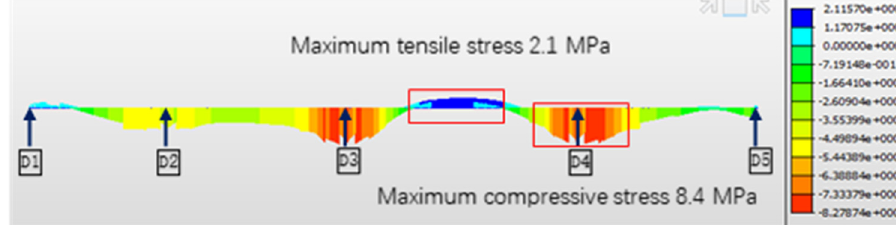
Figure 15. Maximum stress values of bridge concrete.